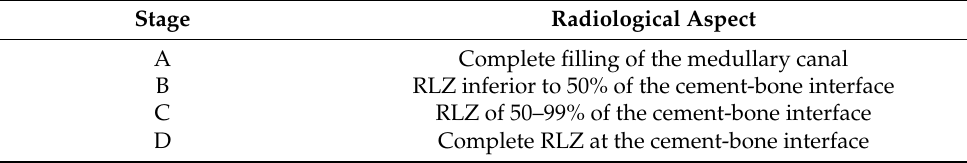
Table 2. Barrack